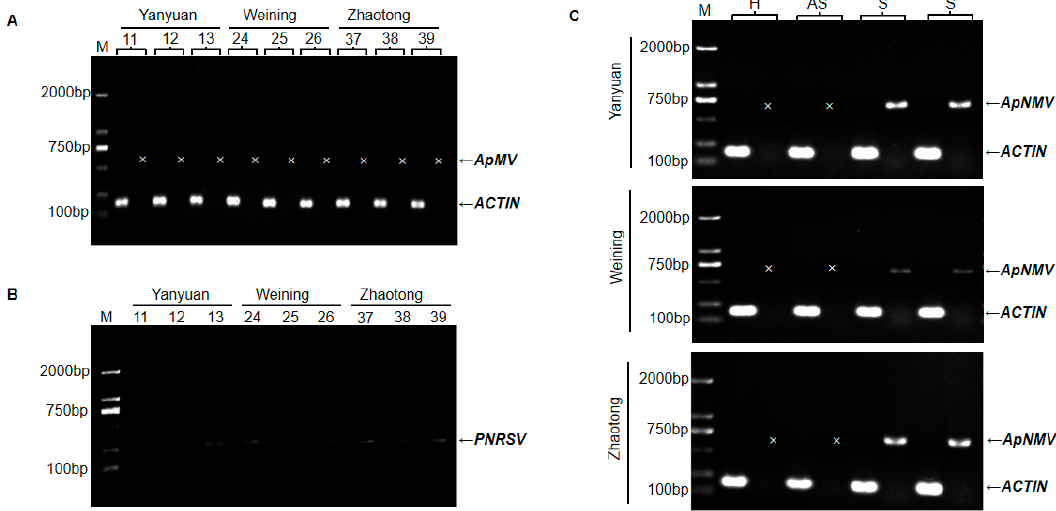
Figure 2. Identification of apple mosaic virus (ApMV) ( A ), prunus necrotic ringspot virus (PNRSV) ( B ), and apple necrotic mosaic virus (ApNMV) ( C ) by RT-PCR. ( A ) Detection of ApMV. Numbers 11 / 12 / 13, 24 / 25 / 26, and 37 / 38 / 39 indicate samples collected from Yanyuan county, Weining county, and Zhaotong city, respectively. ( B ) Detection of PNRSV. Samples are the same as (A). ( C ) Detection of ApNMV. H, healthy leaf as a negative control. AS, asymptomatic leaves from trees with mosaic leaves. S, symptomatic leaves from trees with mosaic leaves. Each sample has two lanes, the left one indicates the product of ACTIN, and the right one corresponds to ApMV or ApNMV. Arrows indicate position of RT-PCR products of ApMV, ApNMV, and ACTIN, severally. M, DNA size marker. The mark ‘x’ indicates none of band at corresponding position. All primer pairs used here were listed in Table S2.